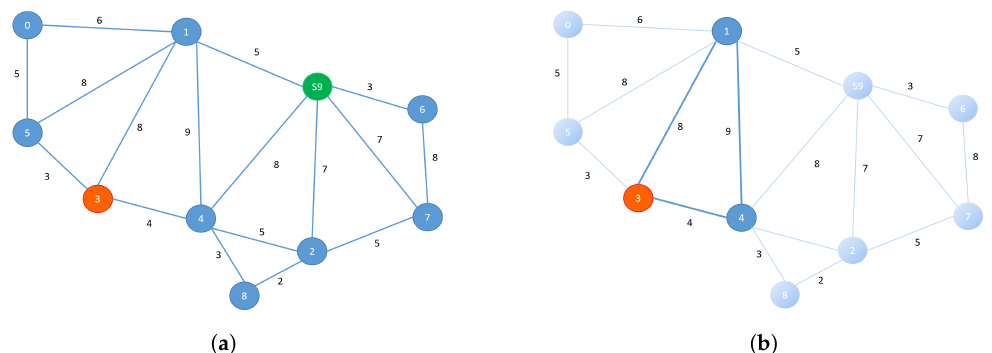
Figure 5. Performing the DLACW in TBIH-5 in an example network ( a ) with node 3 as the current position of vehicle m and node S9 as an emergency shelter. The components for performing the CW are selected in ( b ).